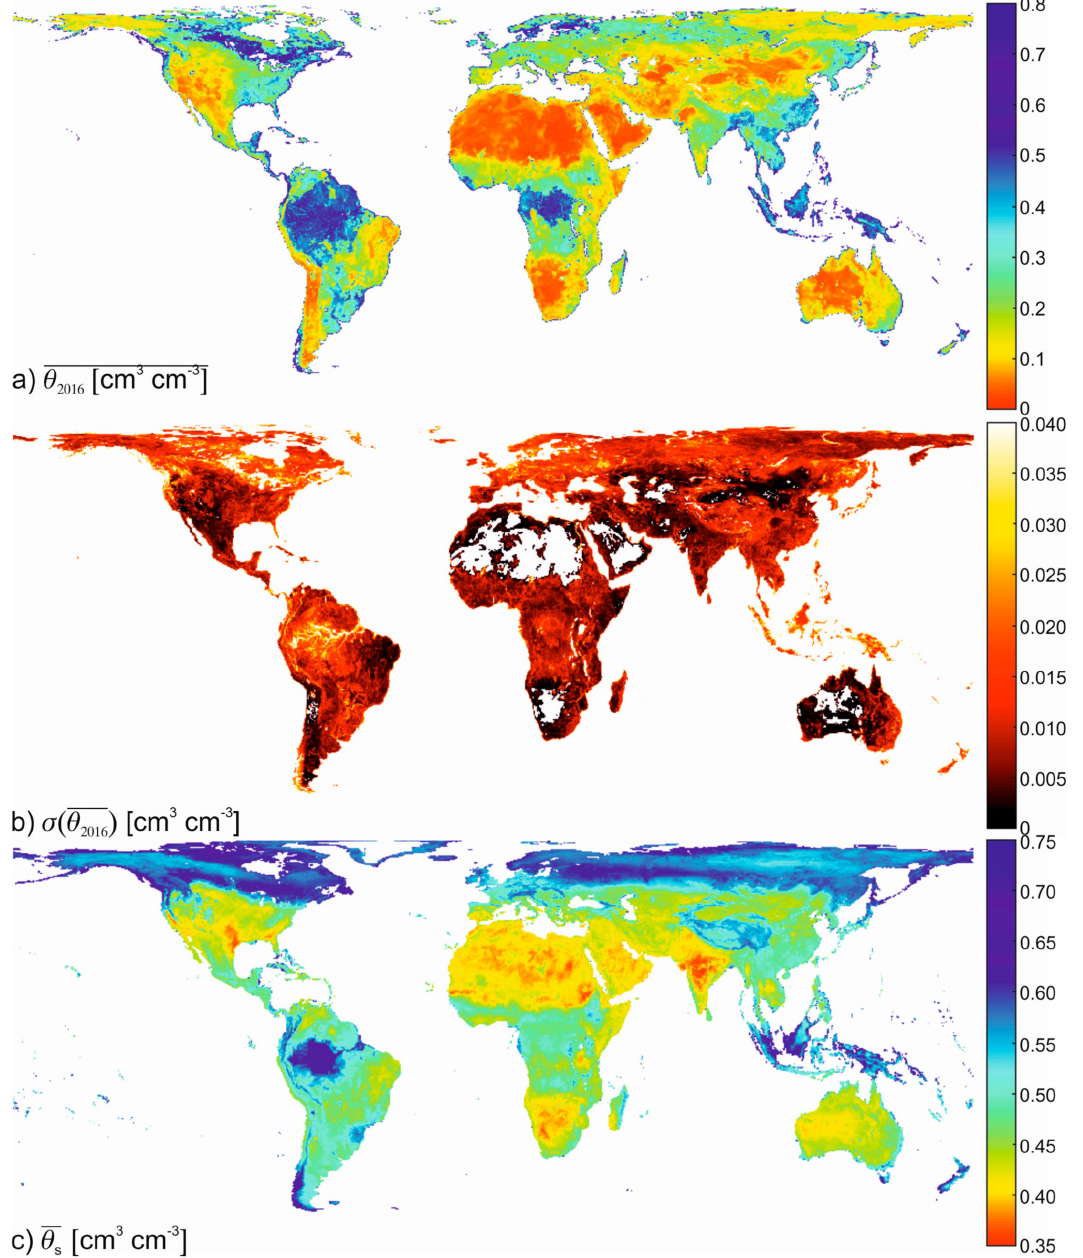
Figure 4. ( a ) SMAP soil moisture annual mean for the year 2016; ( b ) SMAP sub-grid soil moisture standard deviation at 2016 mean soil moisture; and ( c ) mean saturated soil moisture. White regions in ( b ) indicate lower SMAP soil moisture retrievals than residual soil water content θ r parameterization from the Toth et al. [92] pedotransfer function so that σ θ